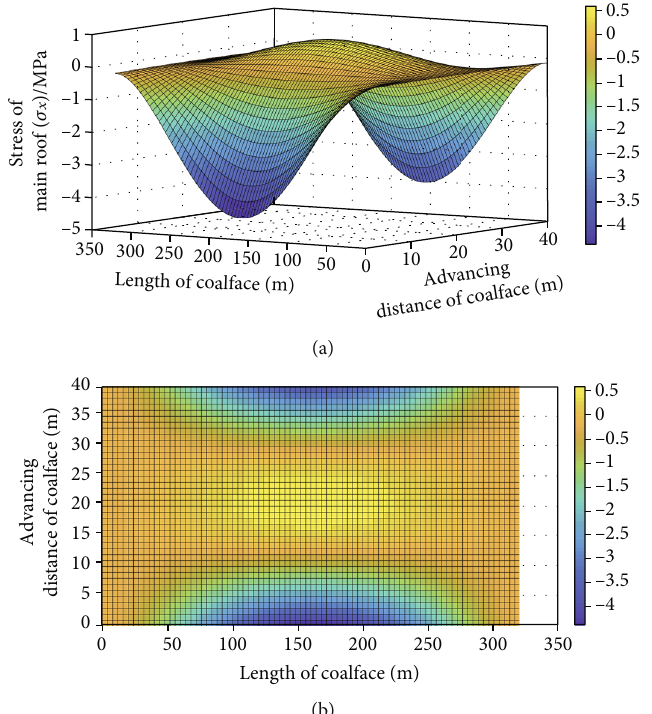
fi rst breaking of the main roof: (a) three-dimensional distribution of the x upon the